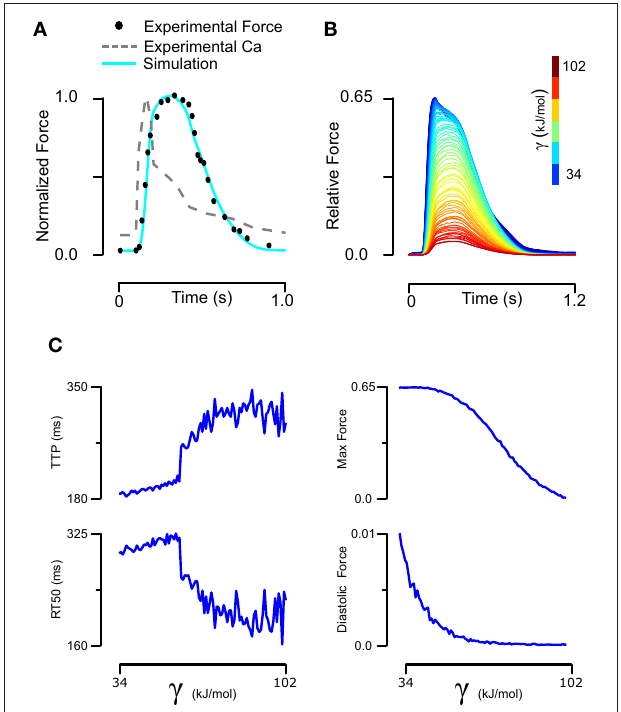
FIGURE 5 | Fitting of intact rat trabeculae twitch with its measured calcium transient and analysis of its sensitivity to stiffness. (A) Baseline parameters maintaining the stiffness of skinned rat trabeculae were found that allowed a model simulation matching the experiment twitch while taking its real calcium transient as an input. (B) The baseline twitch was perturbed by variation of the tropomyosin stiffness. (C) Stiffness had complex effects on the force production and kinetics of twitch, with lower stiffness increasing maximum and diastolic force production while decreasing time to peak but increasing time from peak tension to 50%